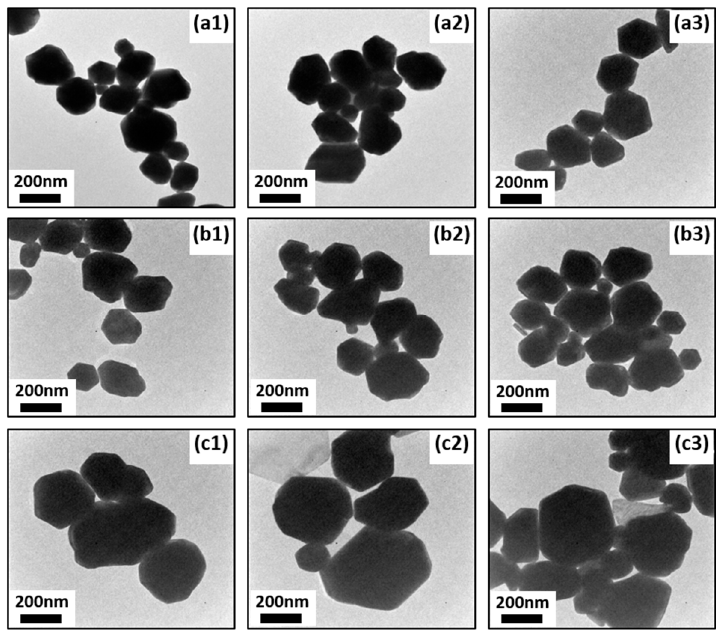
Figure 7. TEM images of Au NPs irradiated by various microwave (MW) MW irradiation times. ( a1 –